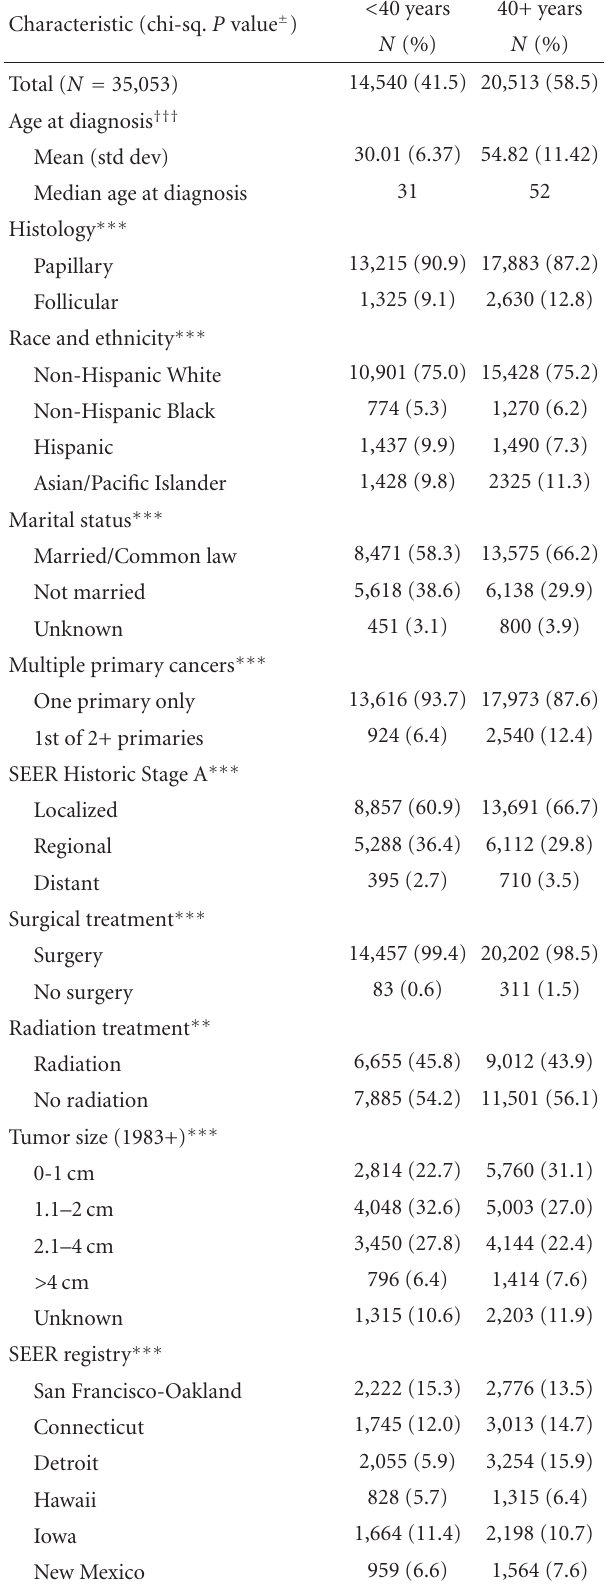
Table 1: Characteristics of women diagnosed with di ff erentiated thyroid cancer 1975–2009 (SEER 9) by age